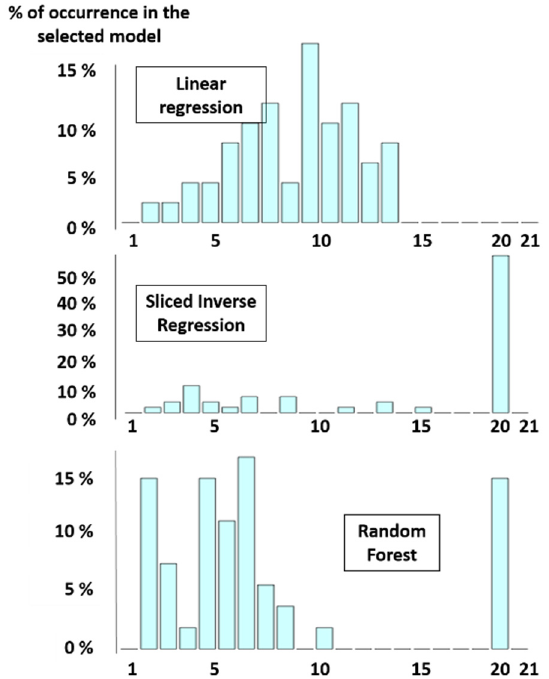
Figure 2. Number of selected variables for three different models (in this example, 21 factors were used to predict the variable of interest, which is tenderness) (adapted from [17]). In this example, 17% of the linear regression (LR) models use 10 variables and all of the LR models use less than 14 variables. On the contrary, 60% of the slice inverse regression (SIR) models use 20 variables out of 21 to predict the parameter of interest. About 15% of the Random Forest (RF) models use 20 variables out of 21 to predict tenderness, whereas, more than 80% of the RF models use between two and eight variables to predict this parameter.